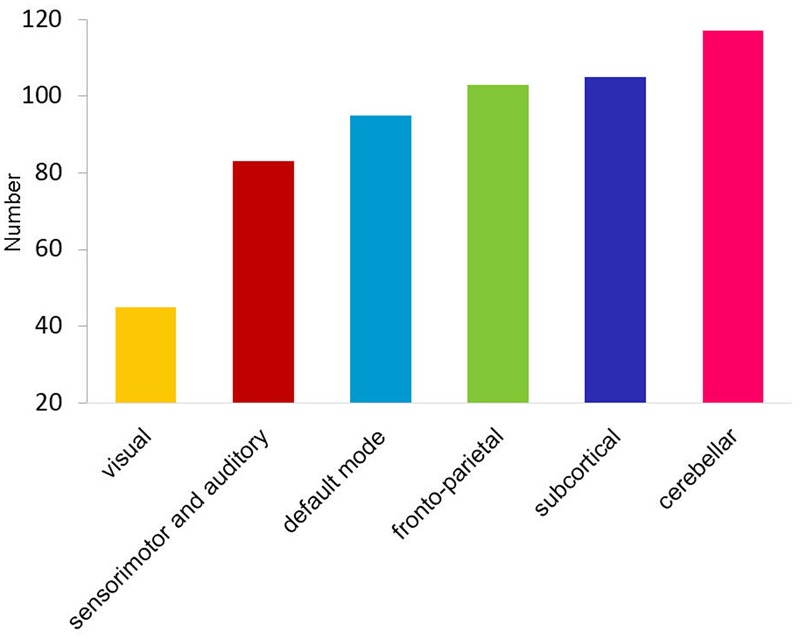
Bar graph shows the ascending order of the total number of cognition-related inter-network connections for each functional network.